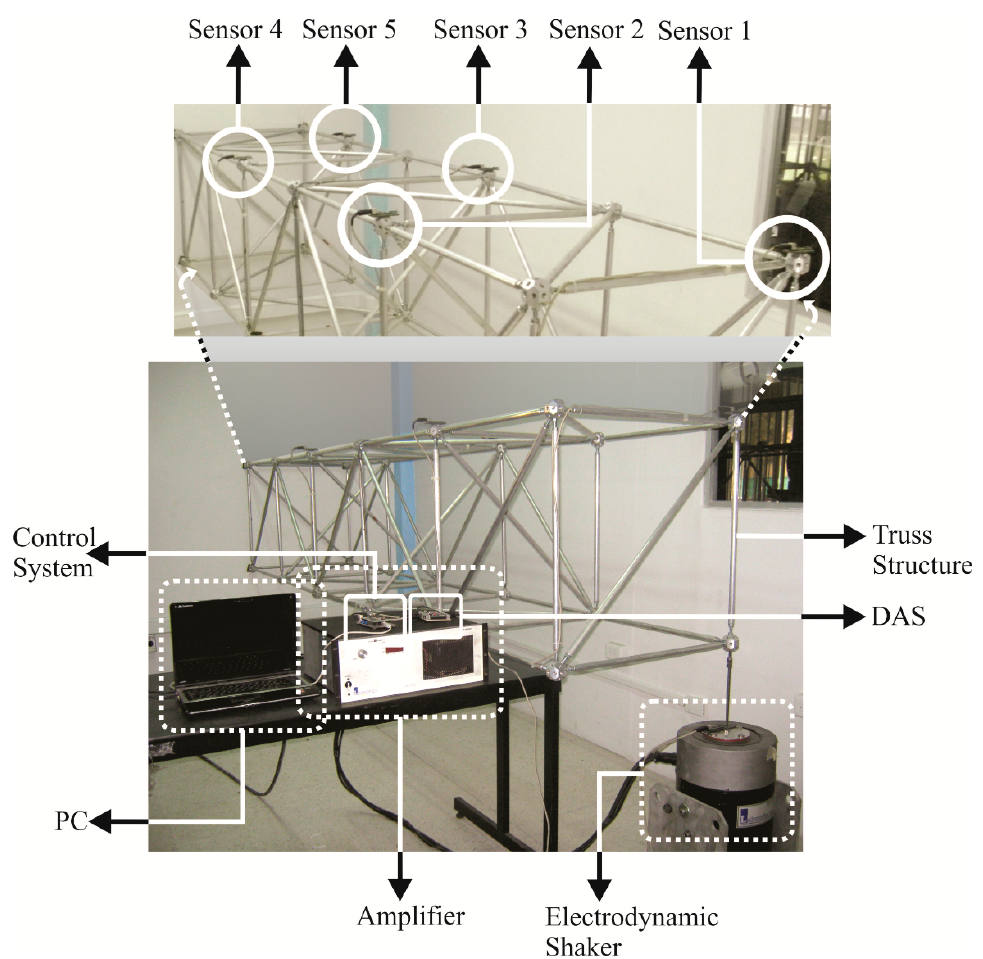
Figure 4. Experimental setup.